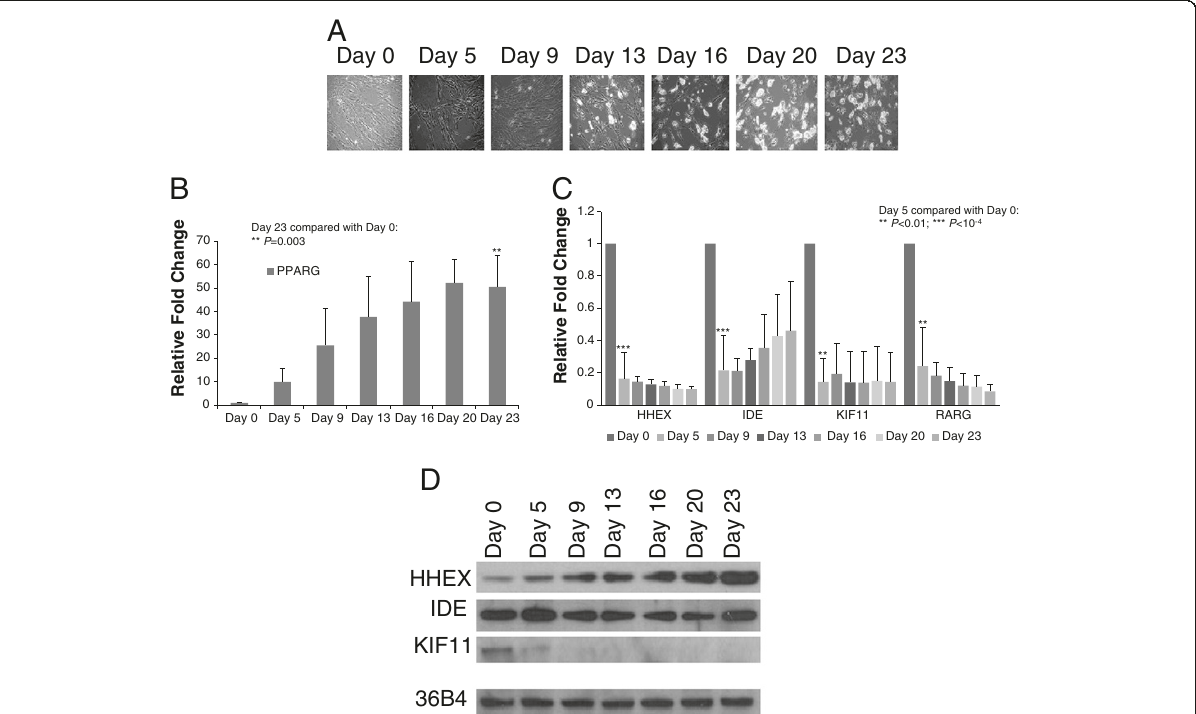
Figure 2 Expression time course of the three genes within the 10q23 locus during adipogenesis in SGBS cells. mRNA and protein were extracted from SGBS cells at given time points (Days 0, 5, 9, 13, 16, 20 and 23) following introduction of the differentiation medium supplemented with Rosiglitazone. Confocal images of the SGBS cells are presented at each of these time points ( A ). Real-time PCR normalized for 36B4 mRNA expression ( B , C ) and Western blots ( D ) were carried out to measure either mRNA or protein levels of the gene of interest, respectively. Standard deviations were calculated based on three independent mRNA replicates. A representative Western blot result is